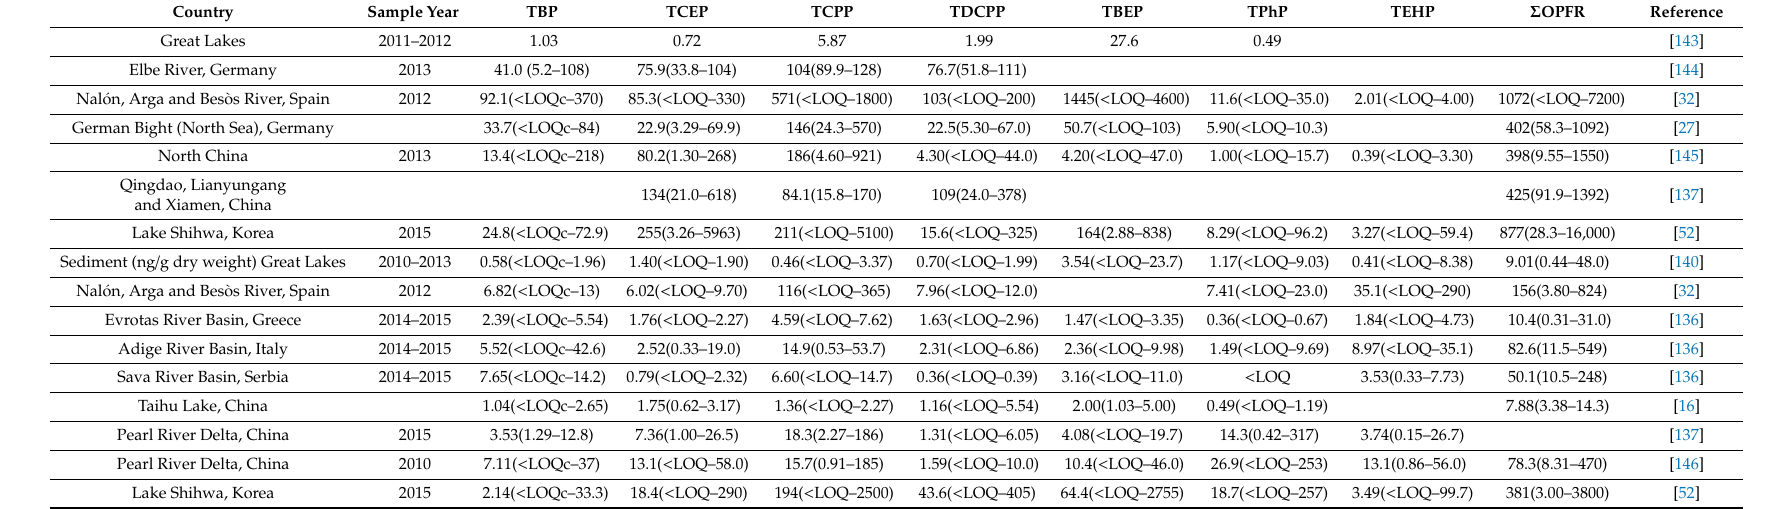
Table 3. Summary of mean (min-max) concentrations of OPFRs in water and sediment measured in previous studies (ng /